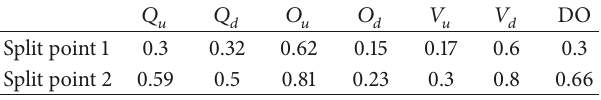
Table 3: The parameters of 𝑄 𝑢 .